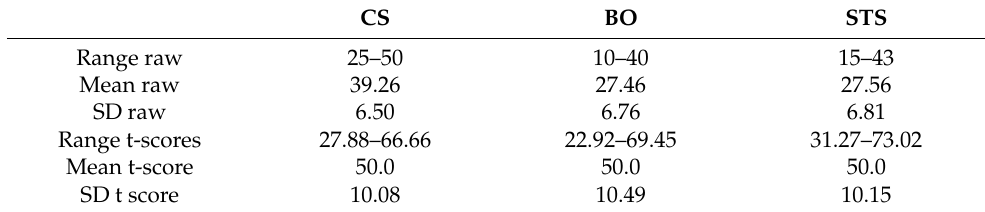
Table 1. Descriptive statistics for raw and t-scores.